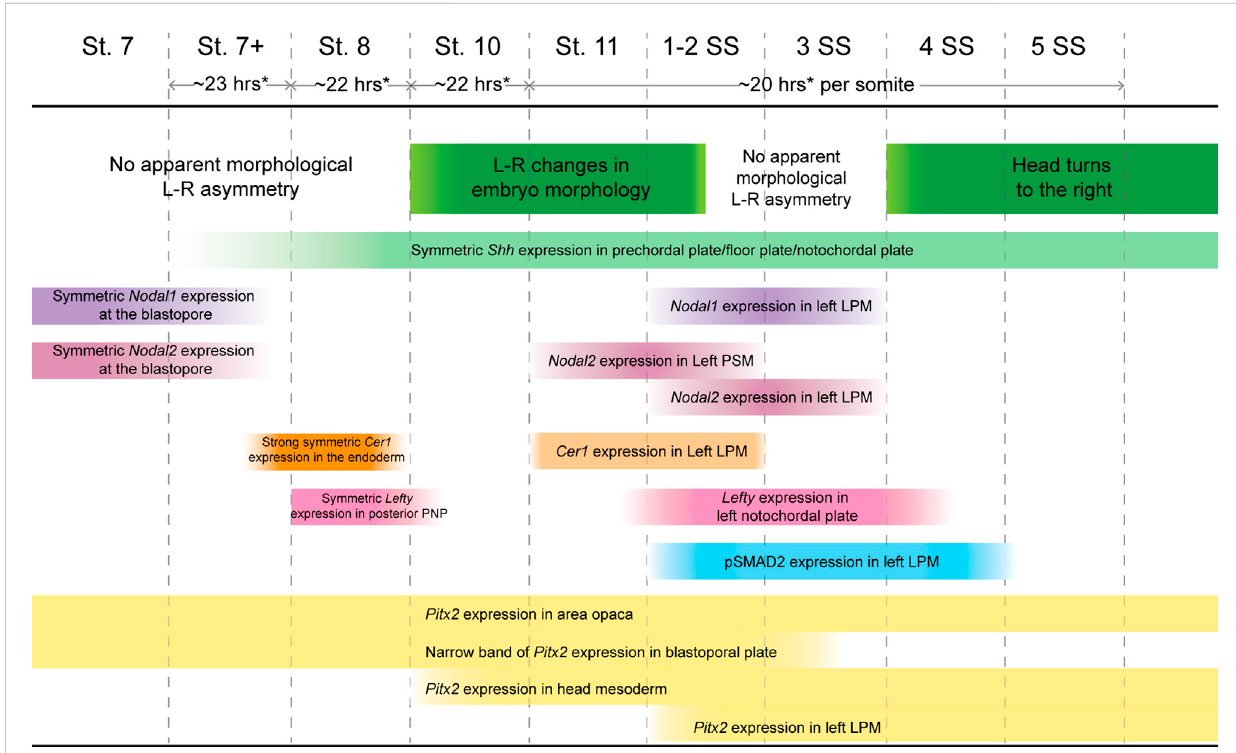
FIGURE 7 Timing of Nodal cascade markers expression and morphological changes in veiled chameleons.Temporal changes in the embryo set in the context of changing molecular markers expression, their pattern and intensity in the Nodal cascade. Left-right (L-R), lateral plate mesoderm (LPM), presomitic mesoderm (PSM), prospective notochordal plate (PNP). * Timing of development determined approximately for embryos incubated at 30 ° C. Development is slower at lower